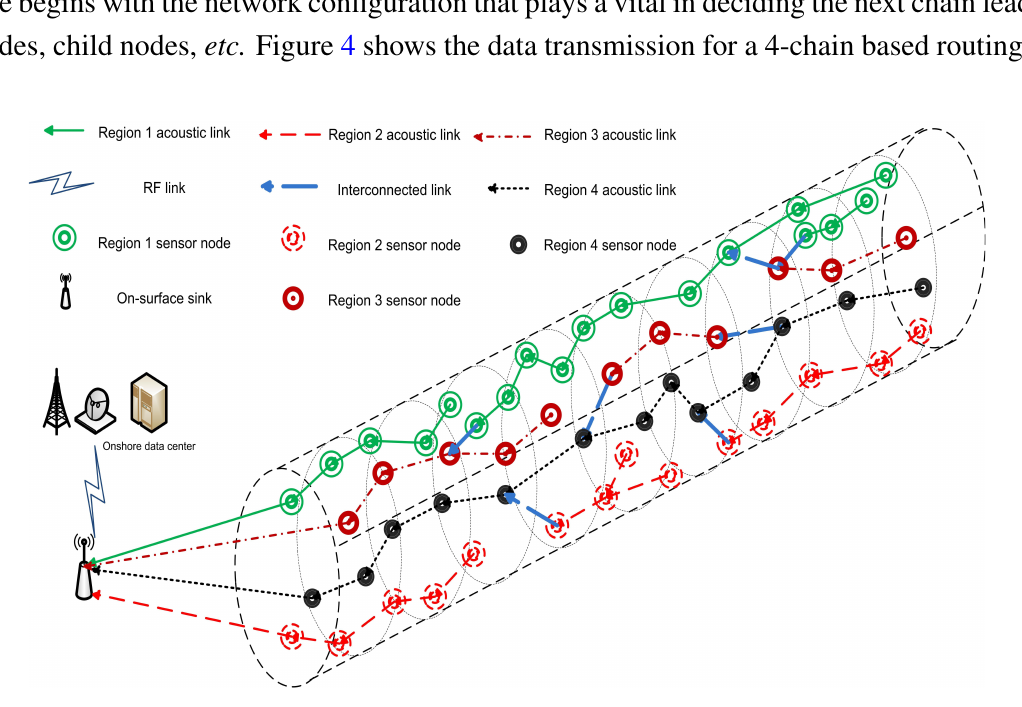
Figure 4. 4-chain based